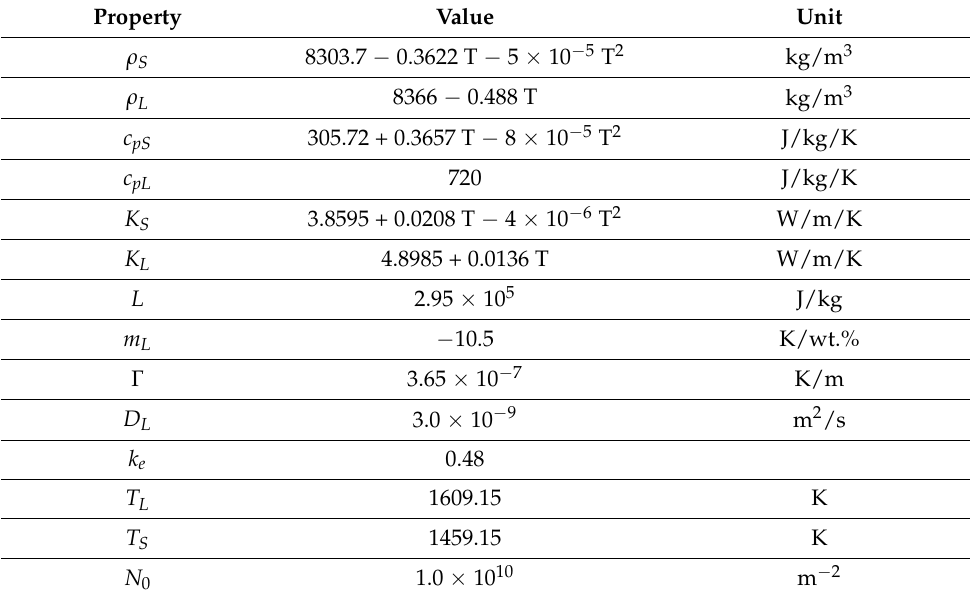
Table 1. Themo-physical and material kinetics properties of IN718 [9,10,27–30].